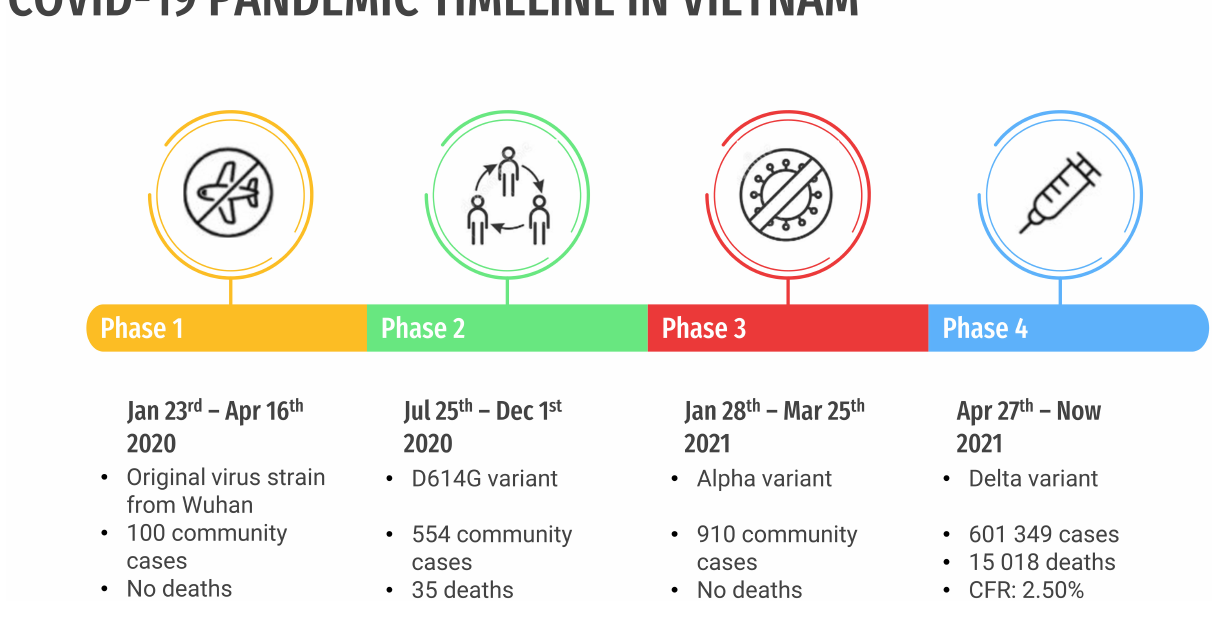
FIGURE 1 | Four waves of the COVID-19 pandemic of